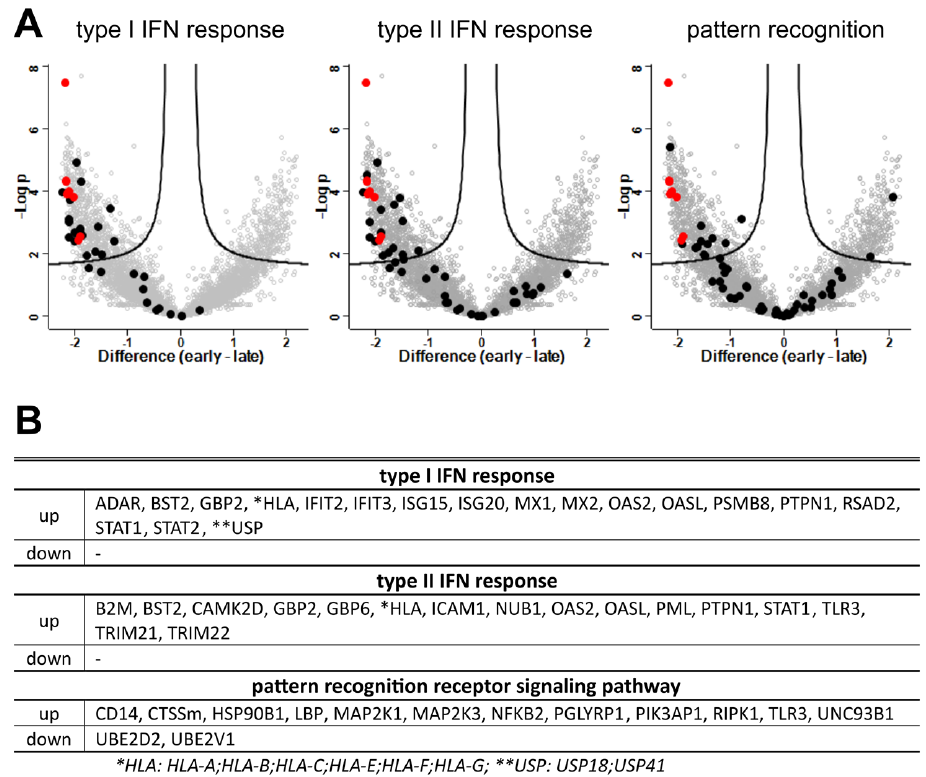
Figure 10. Differentially expressed genes (DEG) in late and early phases of infection: virus proteins, type I IFN response (GO: 0071357), and response to IFN gamma (GO:0034341). ( A ) Volcano plots highlight genes annotated within GO-terms response to Type I IFN (GO: 0071357), response to IFN gamma (GO:0034341), and the pattern recognition term GO:0002221. NiV proteins are highlighted in red as a reference for upregulated genes. Black dots represent cellular proteins of the respective pathways. ( B ) Regulated DEG corresponding to GO terms. *: No differentiation of the indicated HLAs was possible. **: no differentiation of USP18 and USP41 was possible.